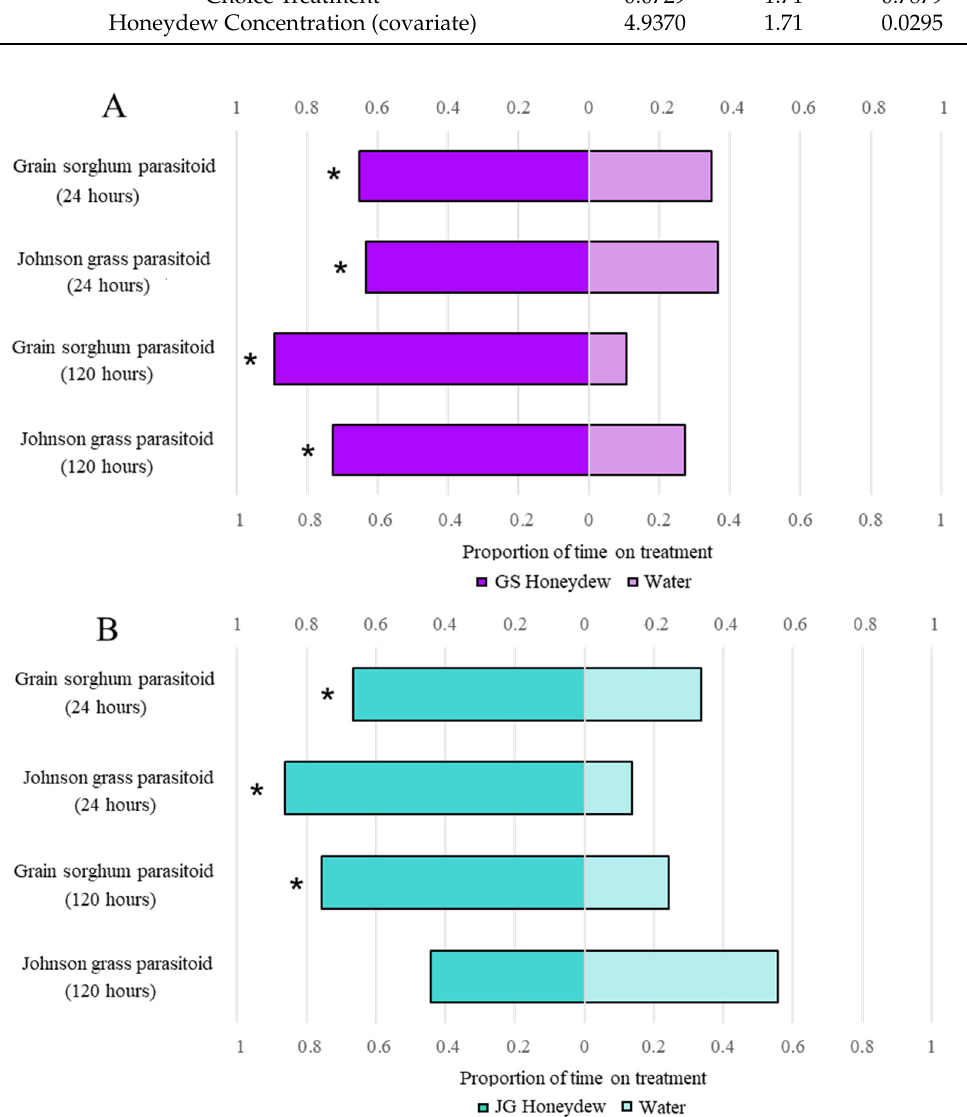
Figure 3. ( A ) Grain sorghum and Johnson grass parasitoid retention is greater on grain sorghum honeydew. ( B ) Grain sorghum and Johnson grass parasitoid retention is largely greater on Johnson grass honeydew. As per a one-sample t -test, an asterisk indicates statistical significance at p < 0.05.